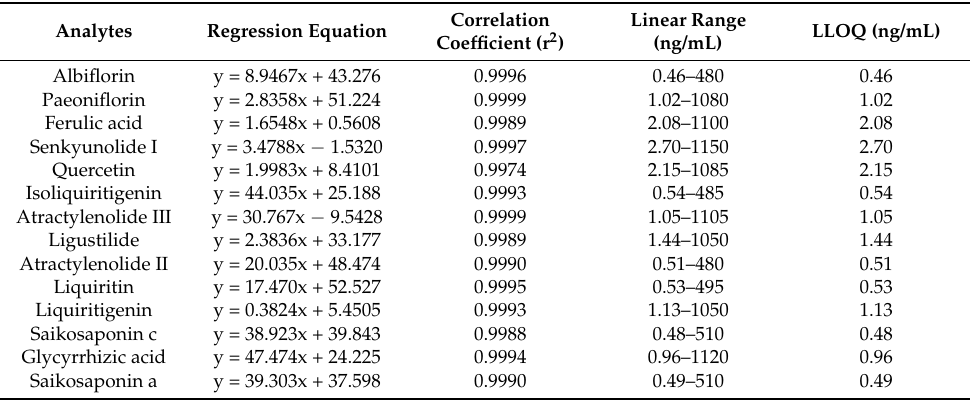
Table 1. Regression equations, linearity and